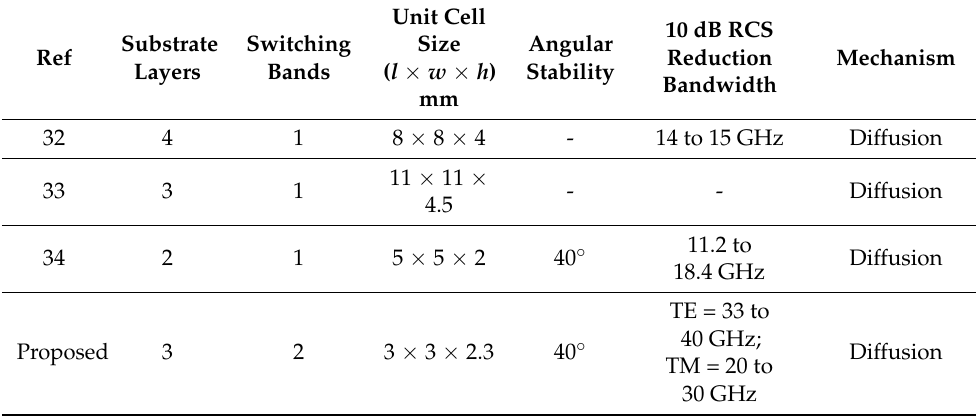
Table 1. Comparison with state-of-the-art reported